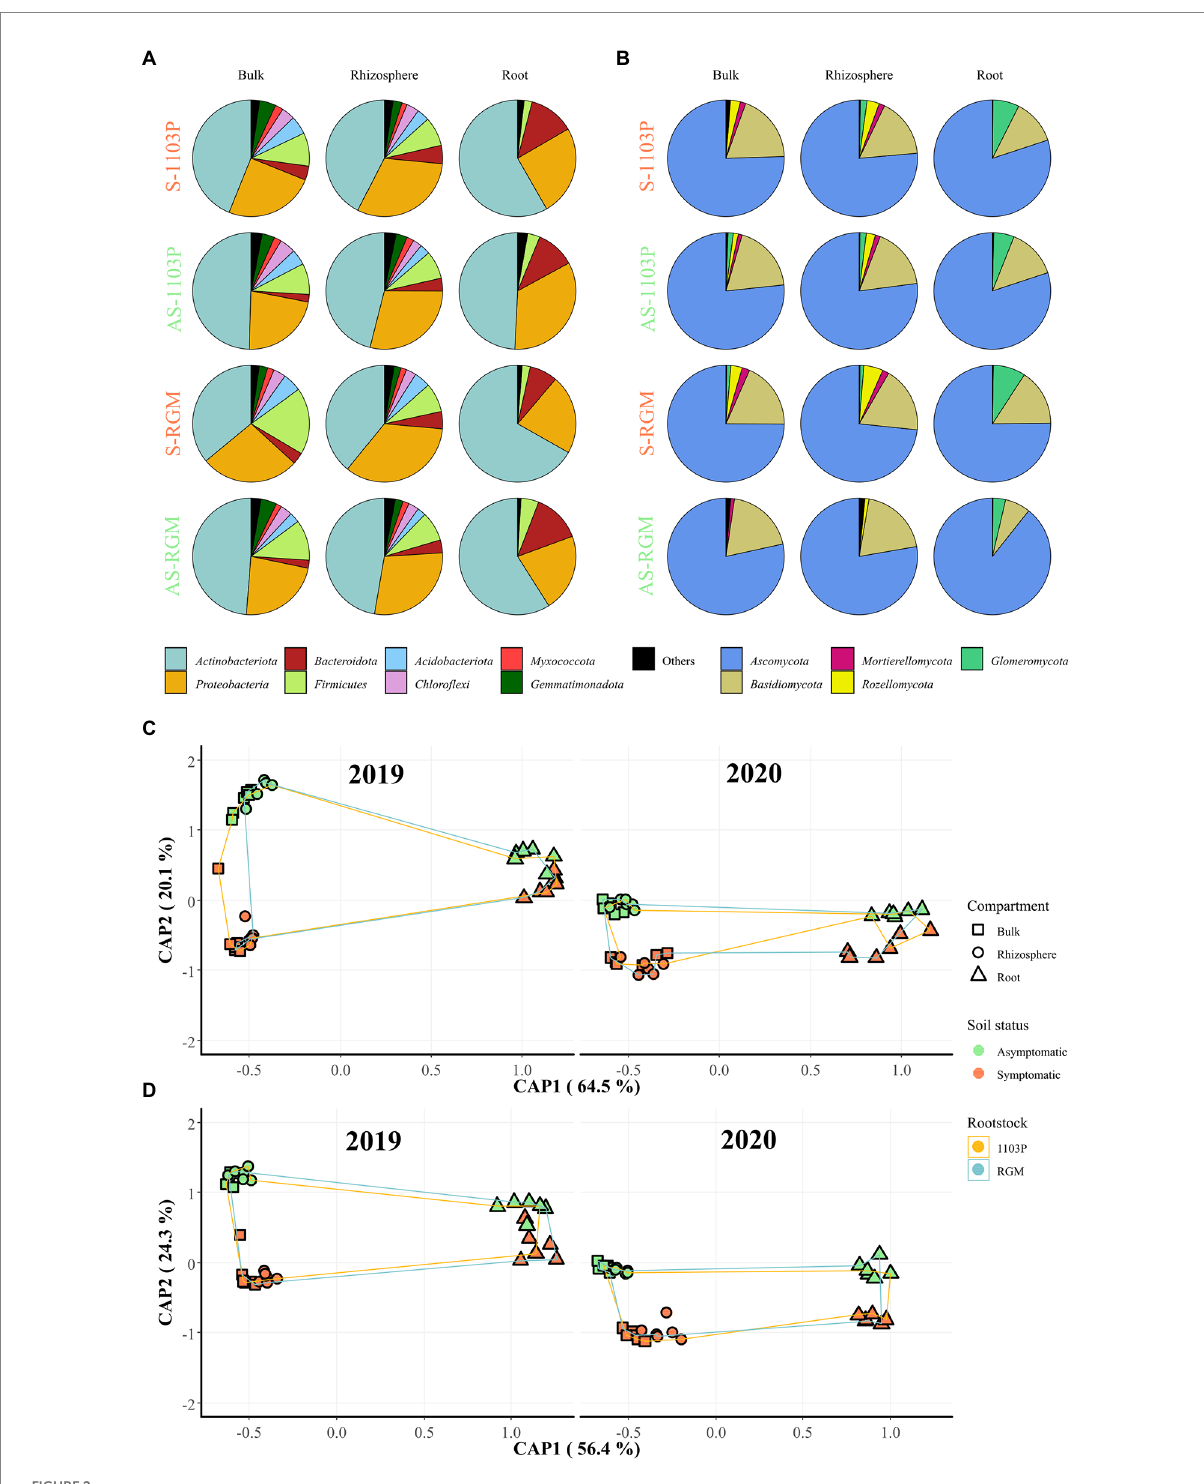
FIGURE 2 Bacterial and fungal communities associated with grapevine rootstocks root systems compartments and bulk soils after 4.5 months of growth in S and AS soils in the greenhouse. CS/1103P and CS/RGM grafted plants were grown either on symptomatic (S-1103P and S-RGM samples, respectively) and asymptomatic vineyard soils (AS-1103P and AS-RGM samples, respectively). The relative abundance at the phylum level in each compartment is represented for (A) bacterial and (B) fungal communities, regardless of year of experiment. Phyla accounting for less than 1% of the total abundance in communities were grouped in “Others.” Constrained analysis of principal coordinates (CAP) of samples by compartment related to CS plants grafted on 1103P and RGM rootstocks grown in symptomatic and asymptomatic soils in greenhouse, is shown for 2019 and 2020 experiments for (C) bacterial and (D) fungal